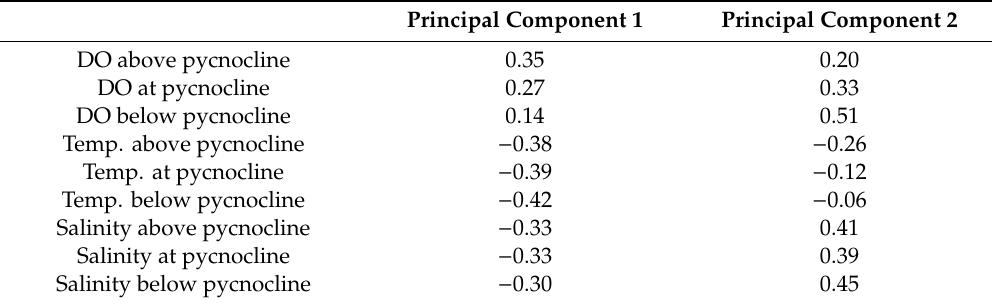
Table 2. Eigenvectors of the principal component analysis of temperature, salinity, and dissolved oxygen (DO) of water sampled by CTD from above, at, and below pycnocline at both the North and South